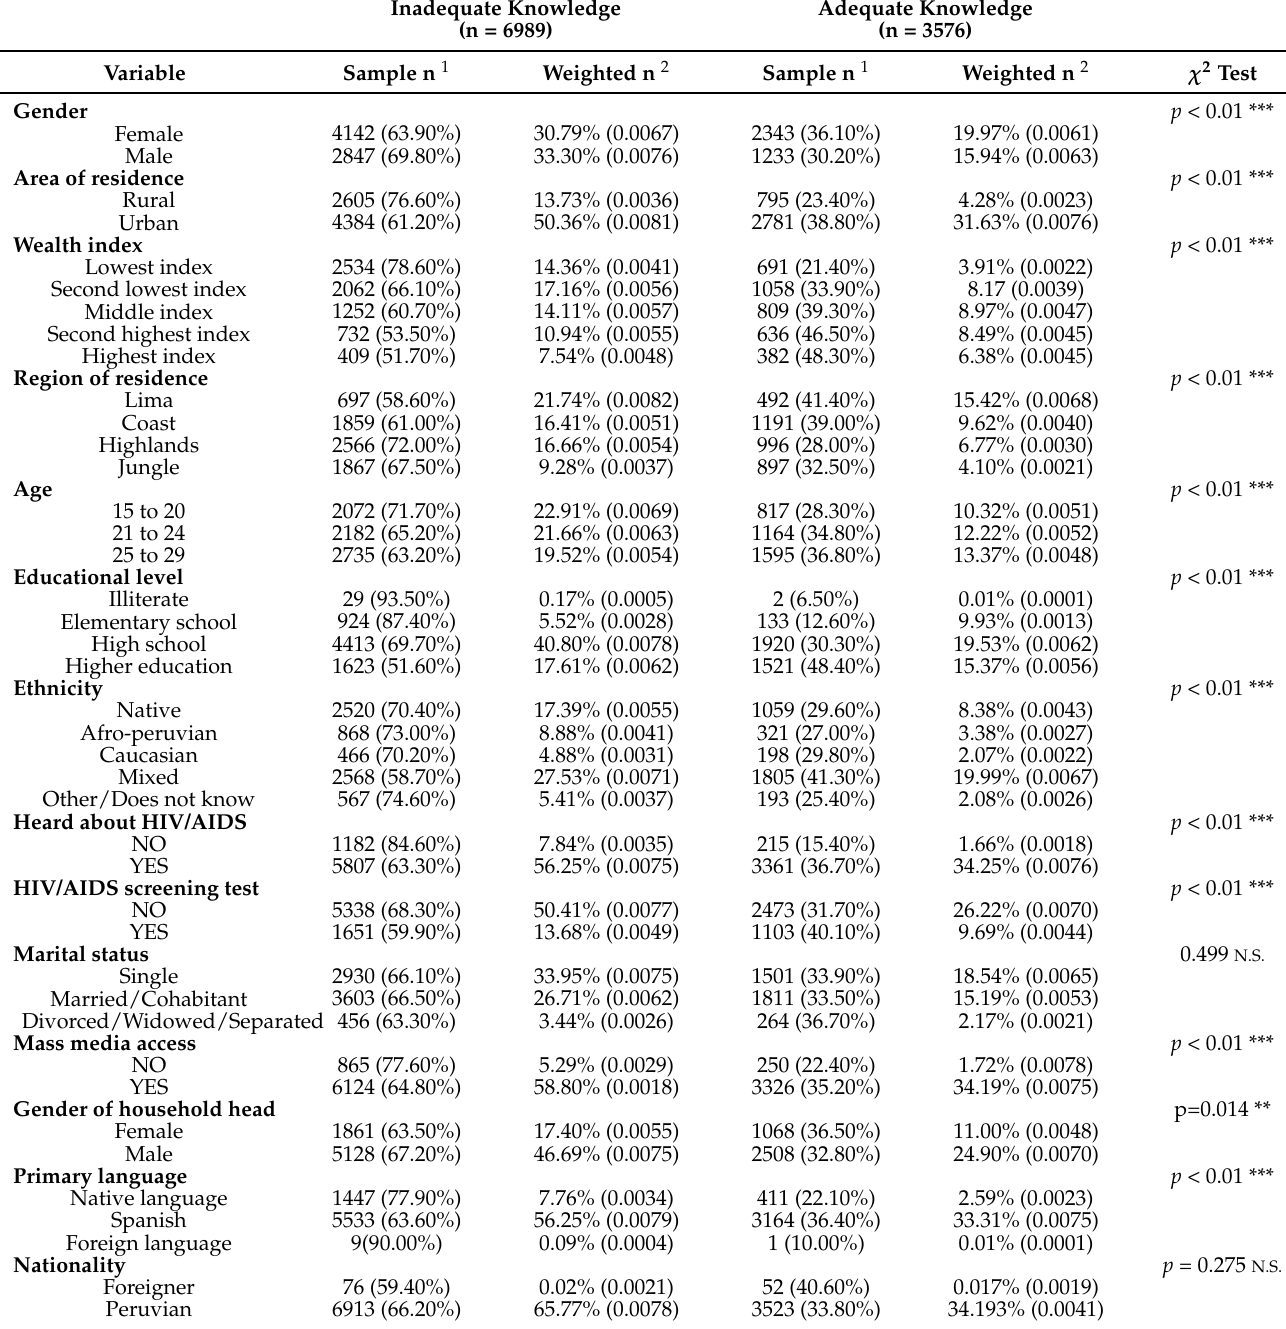
Table 3. Statistical analysis of socio-demographic, economic and health factors according to the knowledge about